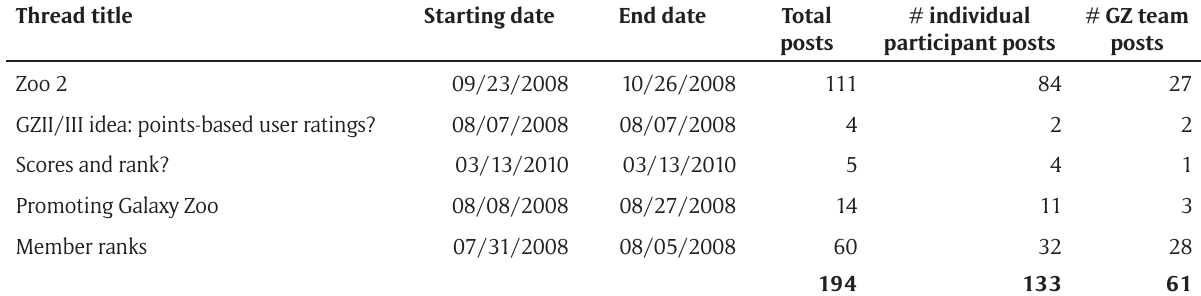
Table 2: GZ threads selected for the analysis.